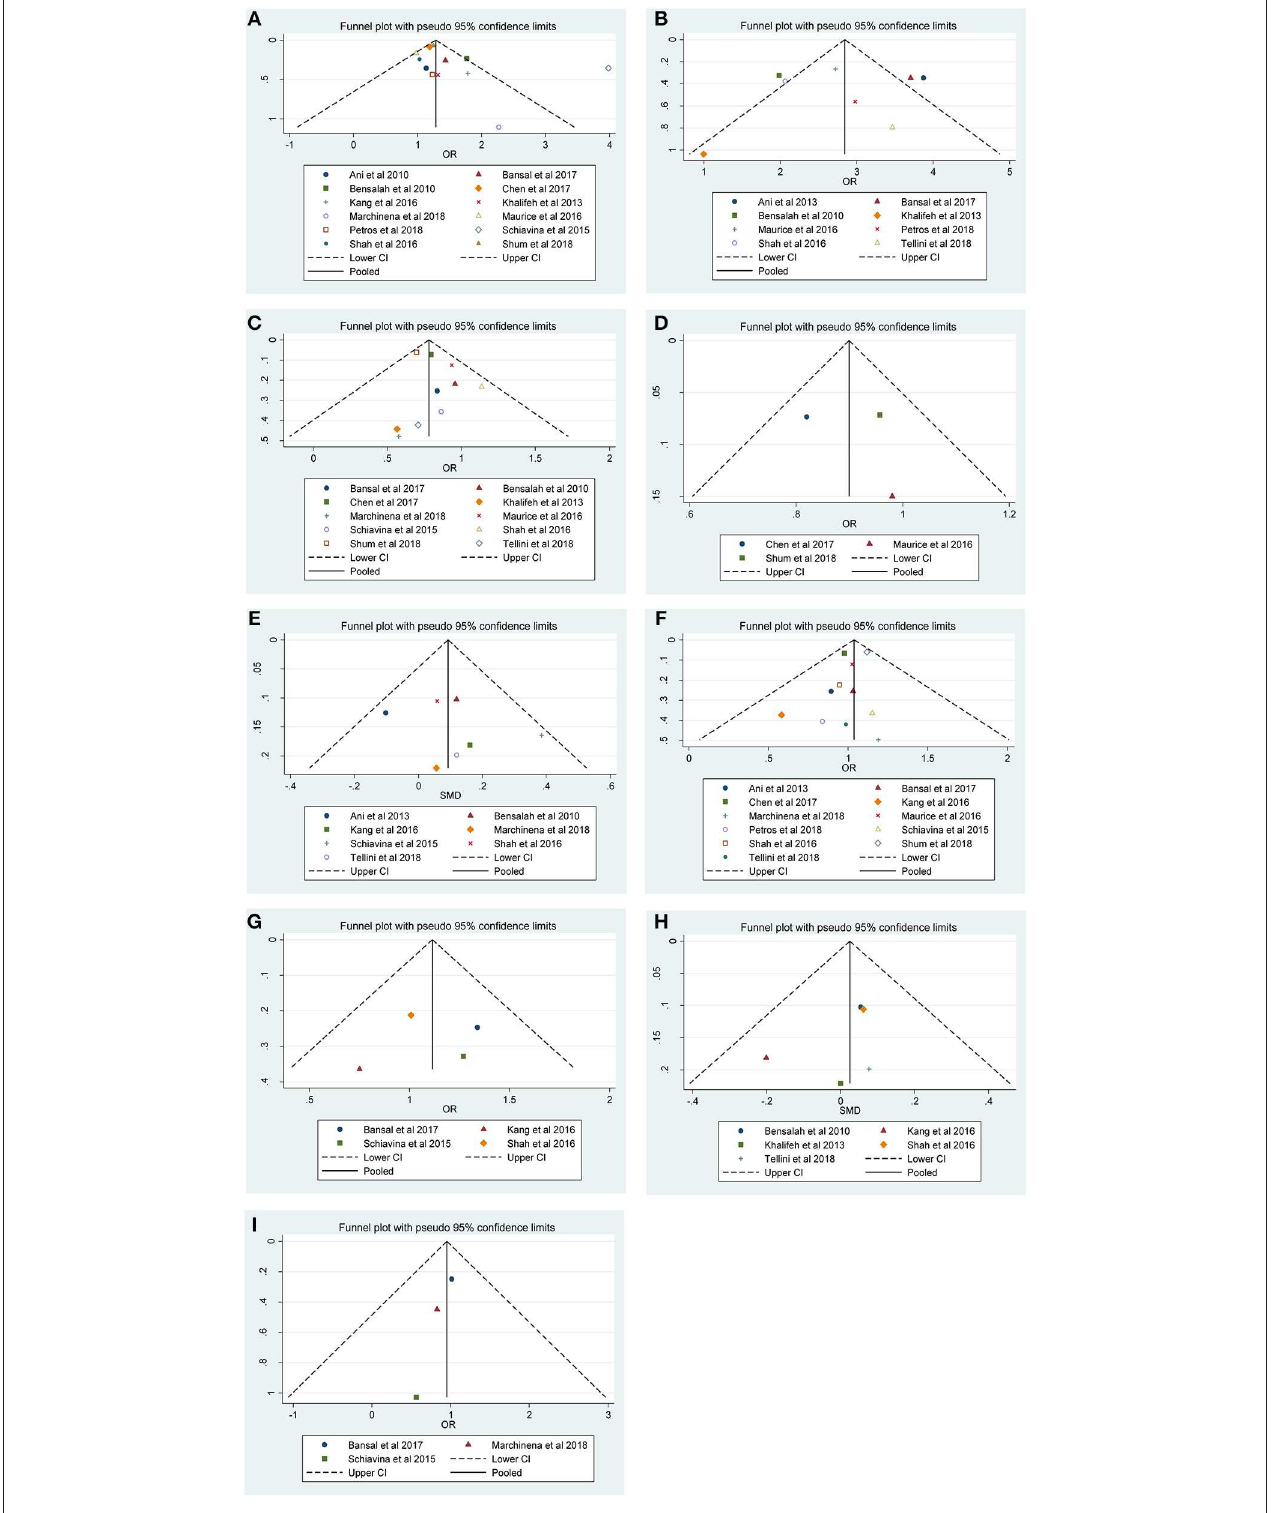
FIGURE 4 | Funnel plots and Begg’s tests for the evaluation of potential publication bias. (A) Furhman grade, (B) pathological stage, (C) non-ccRCC histology, (D) non-white race, (E) age, (F) gender, (G) tumor laterality, (H) tumor size, and (I) surgical approach.